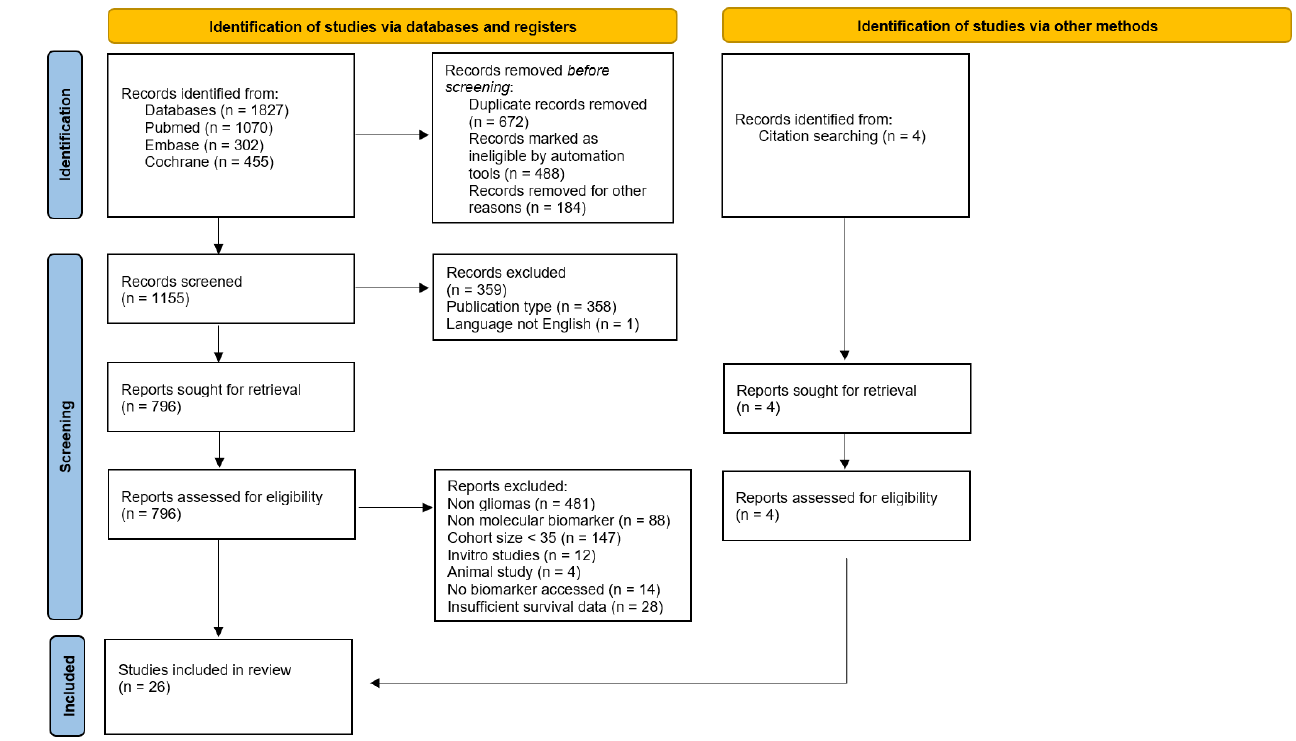
Figure 1. A PRISMA flow diagram of literature screening and exclusion criteria. Table 1. The characteristics of included studies.